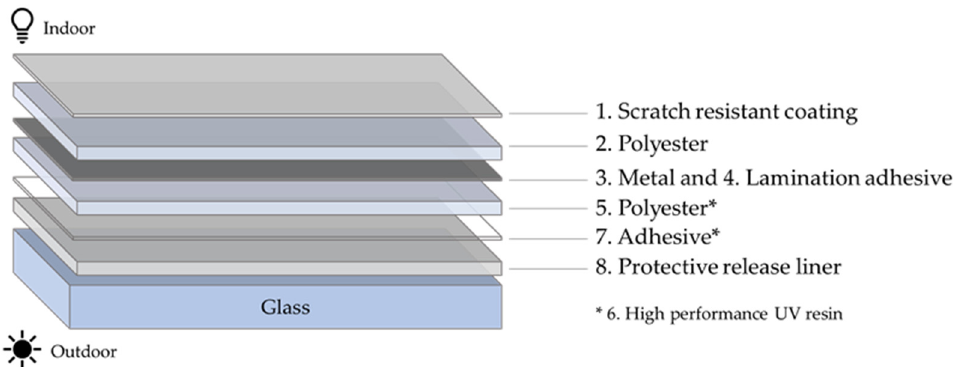
Figure 1. Typical layers of a solar control film with internal application on the glass surface: 1. scratch resistant coating, 2. and 5. polyester, 3. metal, 4. lamination adhesive, 6. high performance ultraviolet (UV) resin, 7. adhesive, and 8. protective release liner. Based on [19].